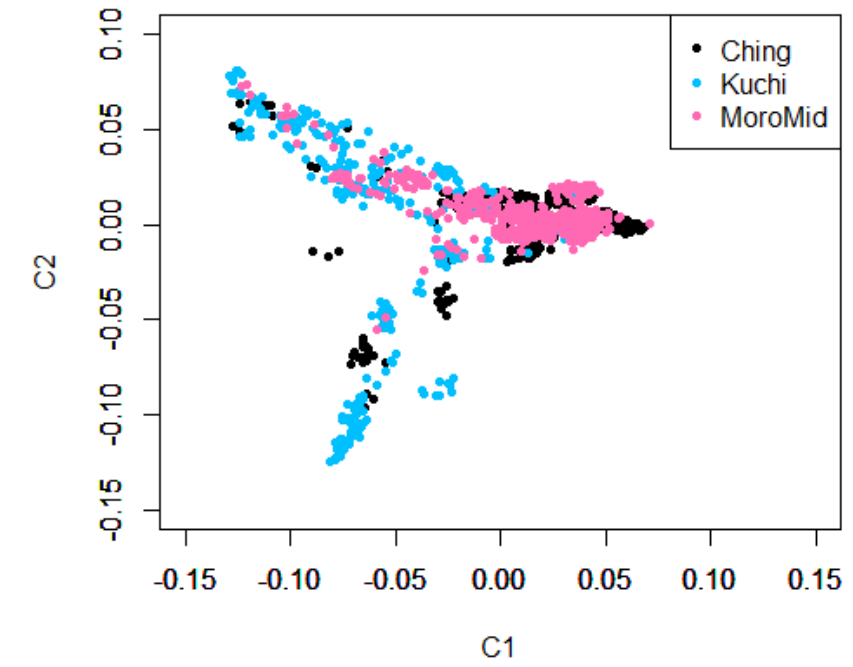
Figure 2. Multi-dimensional scaling (MDS) plot showing the three sampled population ecotypes.